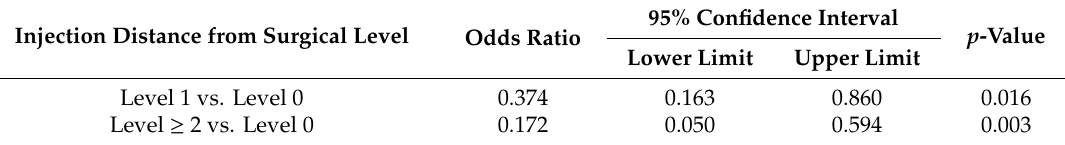
Table 4. Logistic regression analysis for injection distance from surgical level and subdural incidence. Injection Distance from Surgical